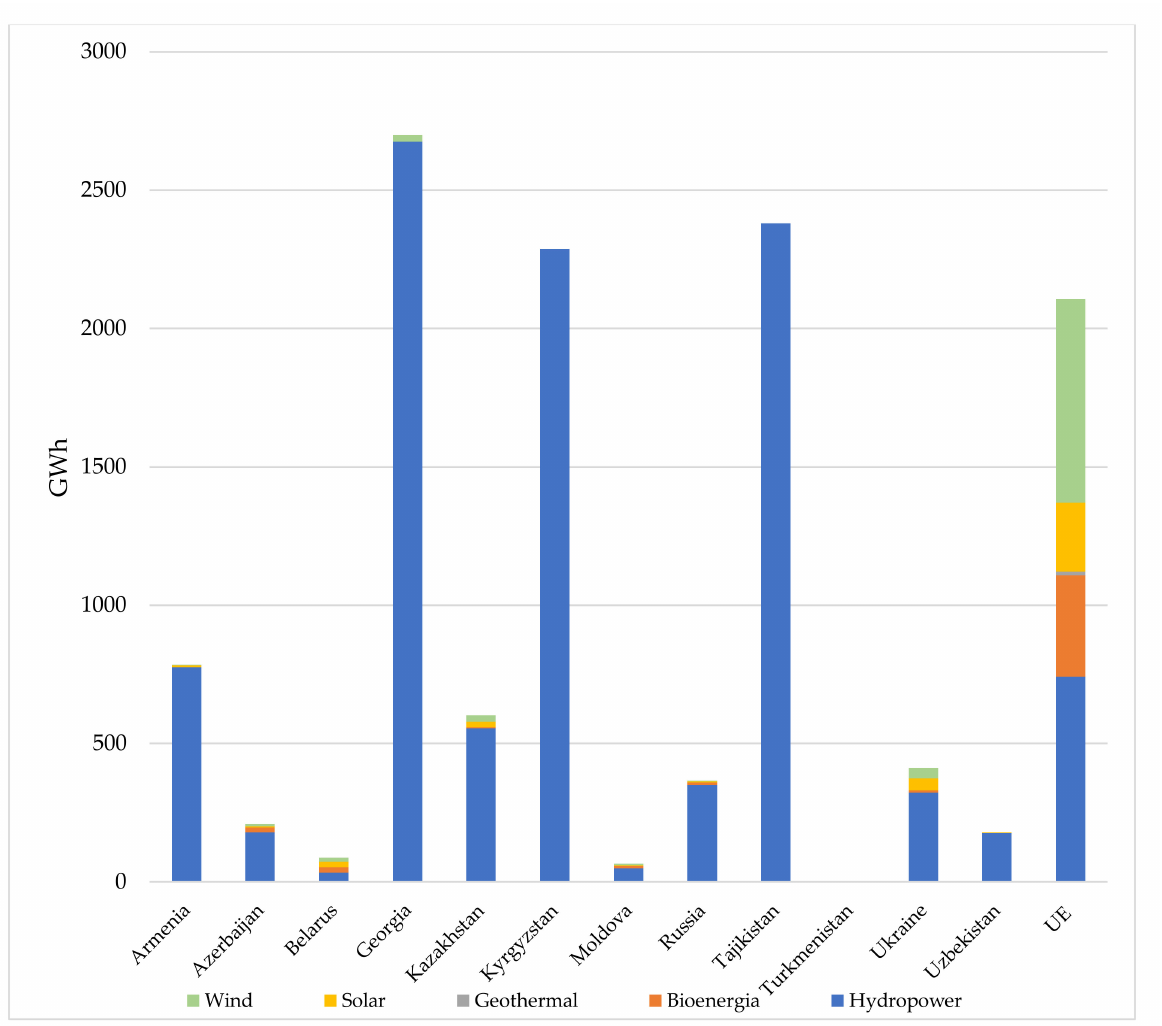
Figure 5. The volume of total production in the CIS in 2018, as per the population count. Source: Own elaboration based on